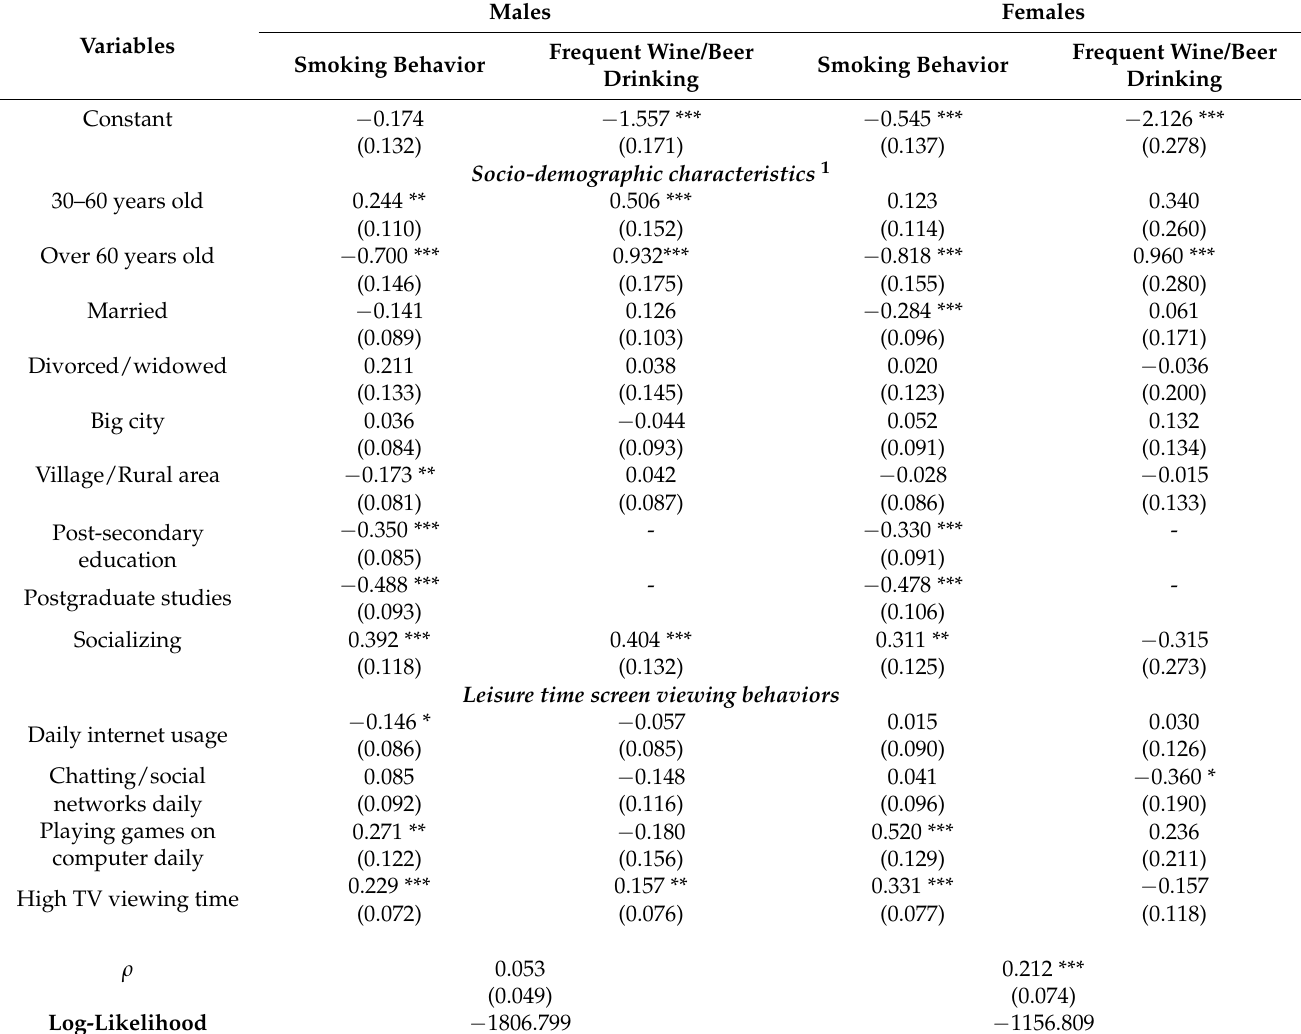
Table 3. Seemingly unrelated bivariate probit model estimates for smoking status and frequent wine and beer drinking.